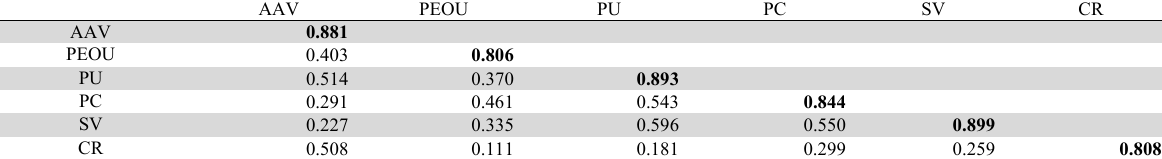
Fornell-Larcker Scale